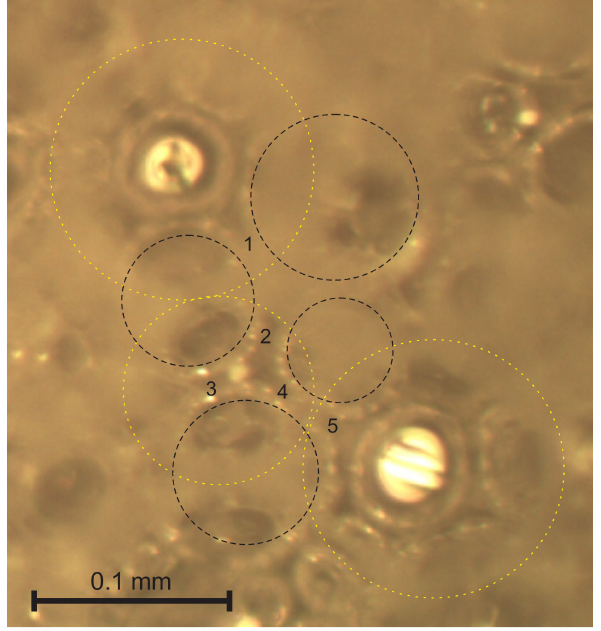
Figure 6. Struts 1–5, each formed between three bubbles, being an upper bubble (yellow) and two lower ones